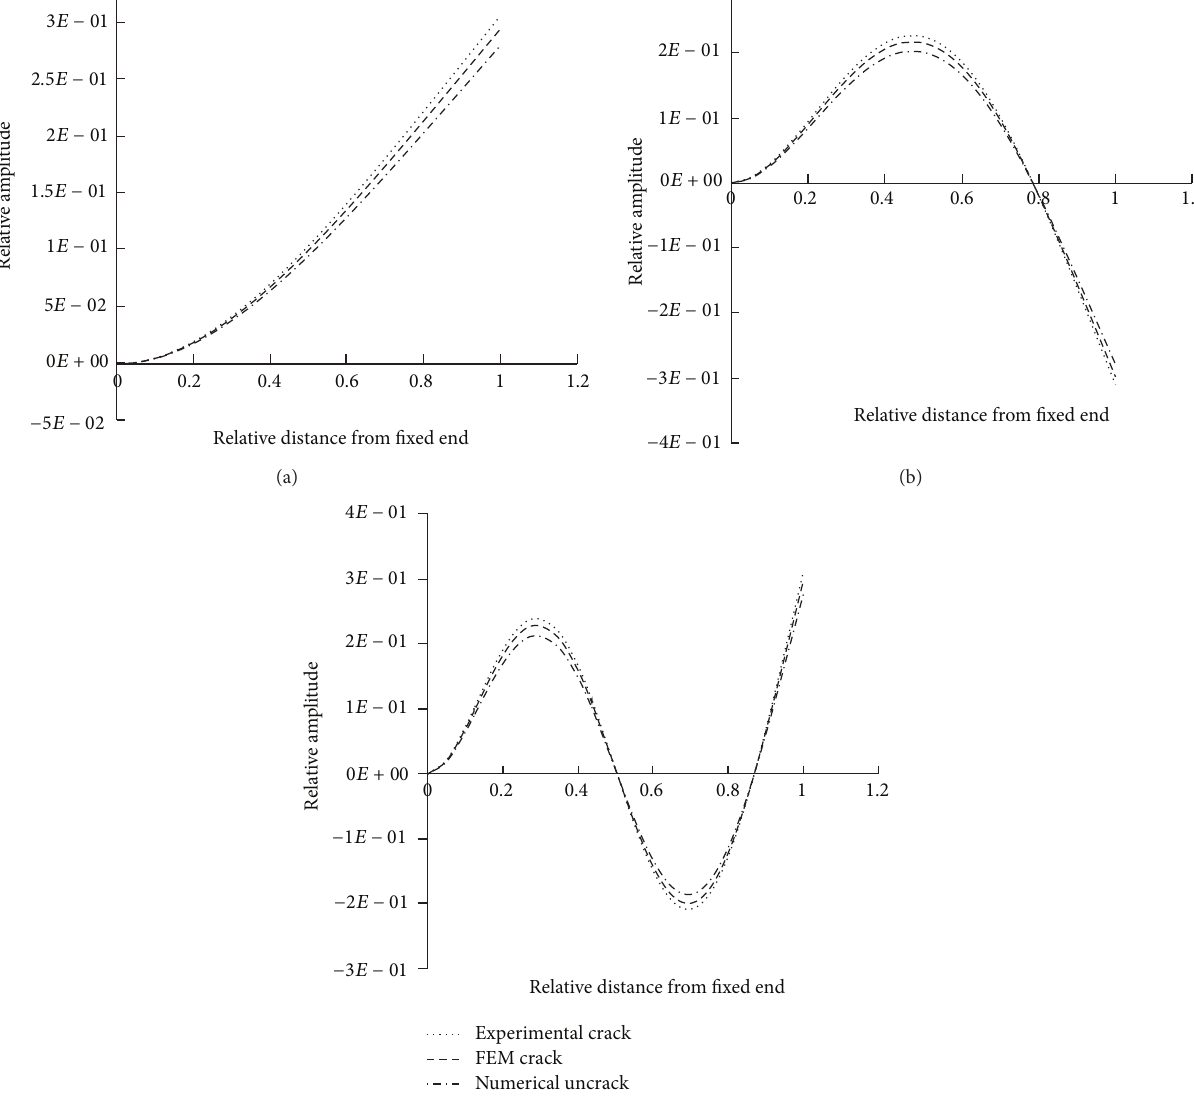
/𝑊 = 0.0833 , 𝑎 /𝑊 = 1 2 /𝑊 = 0.0833 , 1